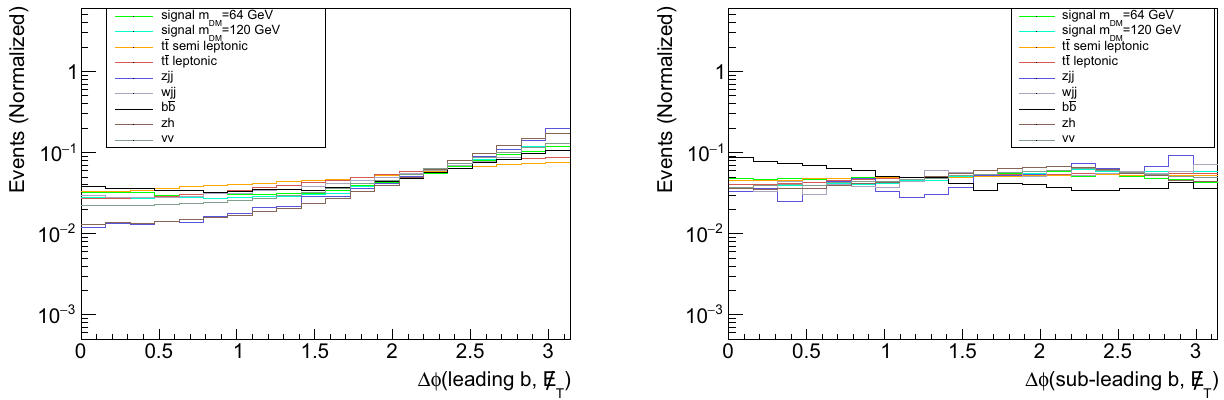
Fig. 15 Normalized (cid:15)φ distribution between the / E T and leading (left) and sub-leading (right) b -jets